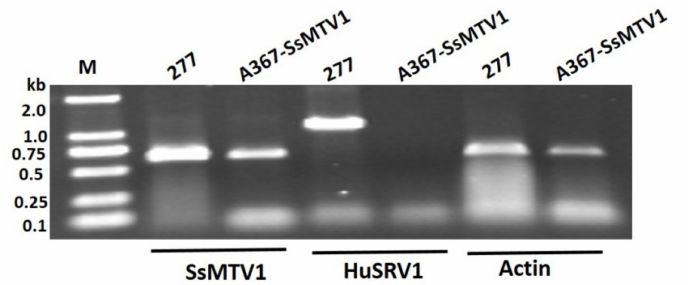
Figure 6. RT-PCR amplification results of the assay of transmission between virus-infected strain 277 and strain Ep-1PNA367R, with primers specific for two viruses (HuSRV1and SsMTV1). The actin gene was used as control. Lane M means molecular weight marker DL2000 (Takara, Dalian,